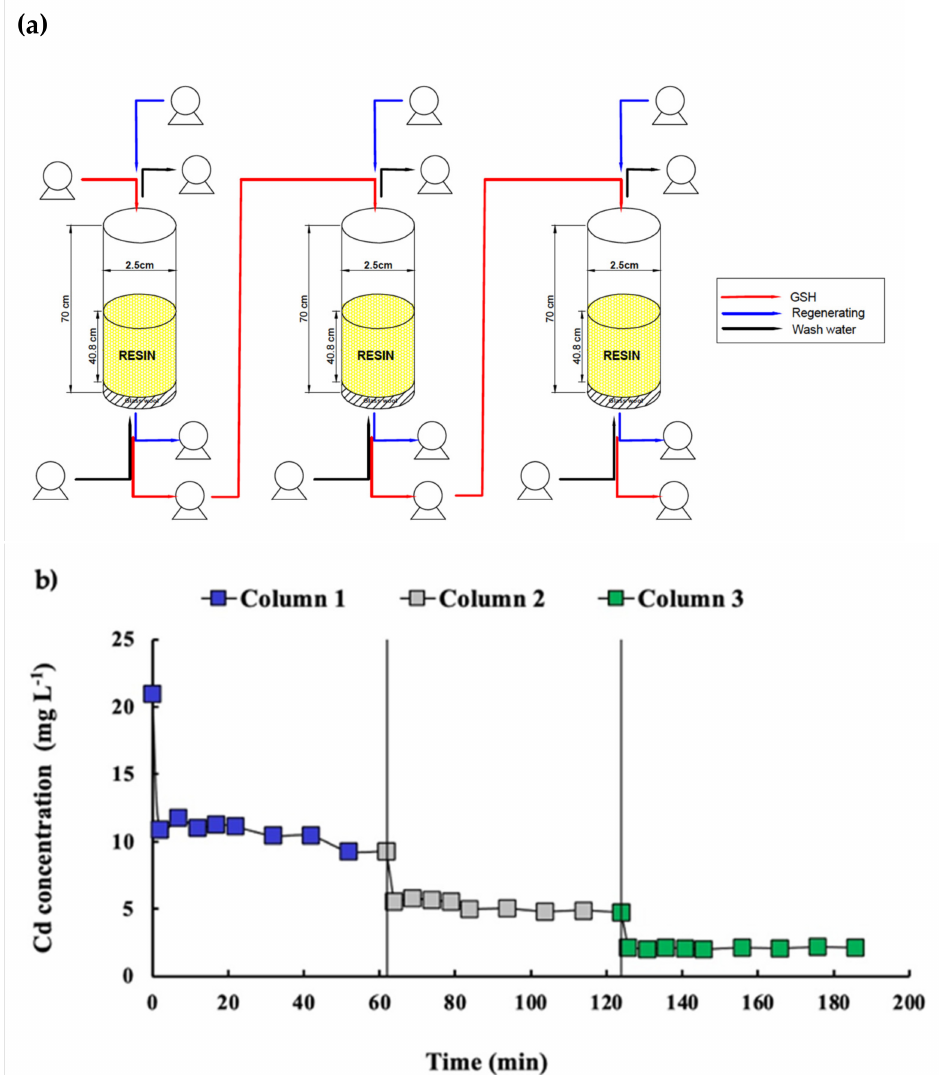
Figure 5. ( a ) Schematic representation of the three columns connected in series . ( b ) cadmium concen- tration performed in the column assay connected in series . The initial cadmium concentration in column 1 was 20.97 mg L − 1 . The final concentration of one column was the inlet concentration of the next column. The final concentration was 2.10 mg L − 1